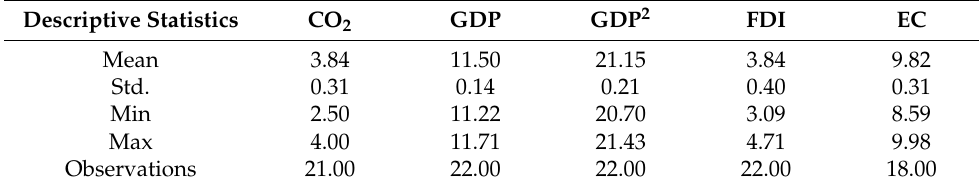
Table 2. Descriptive